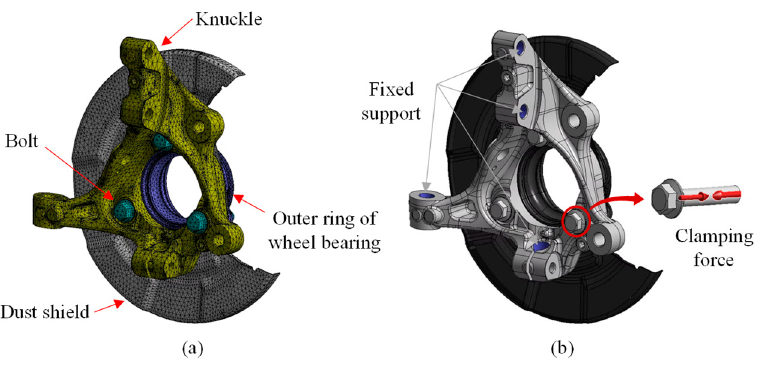
Figure 10. Finite element model of the assembled wheel bearing: ( a ) meshed model and ( b ) boundary conditions.